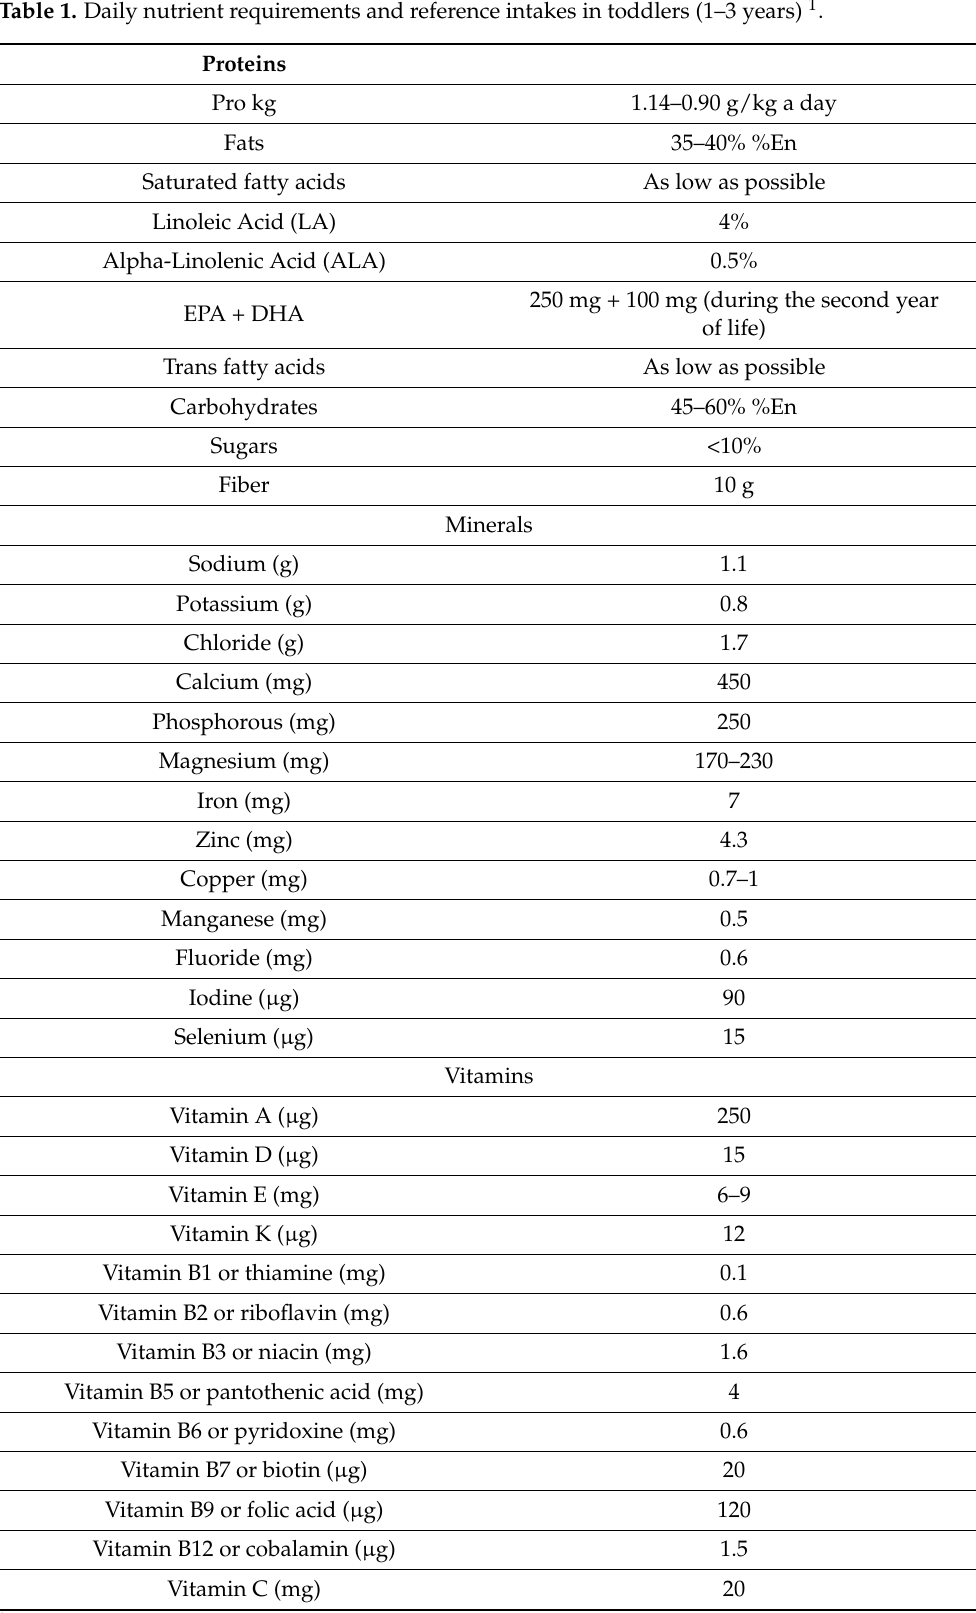
Table 1. Daily nutrient requirements and reference intakes in toddlers (1–3 years) 1